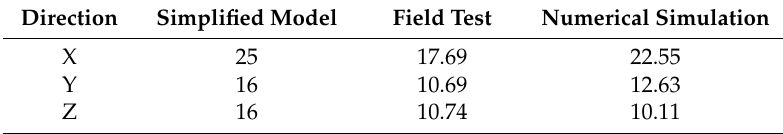
Table 4. Vibration transmission ratios between two adjacent units derived from three methods